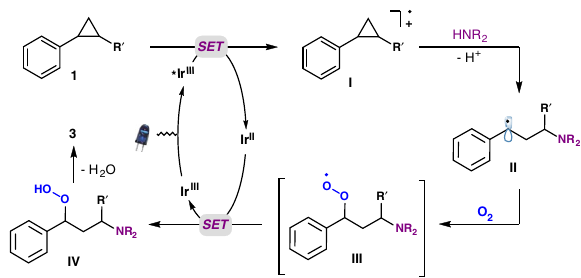
Fig. 4 Proposed reaction mechanism. Single electron oxidation of aryl cyclopropane 1 gives cation radical intermediate I with an activated cyclopropane. Reaction with the nucleophile provides intermediate II, which reacts with dioxygen ultimately affording the product